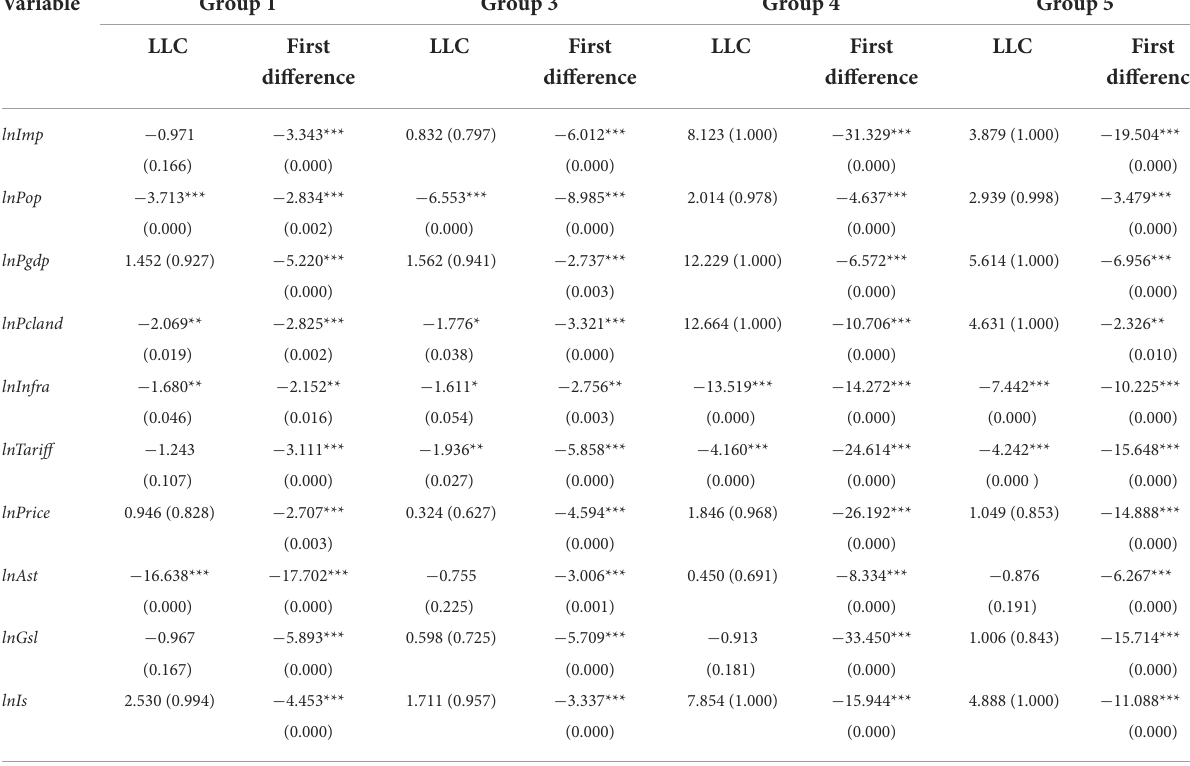
TABLE 5 Outcomes of panel unit root group inspection.